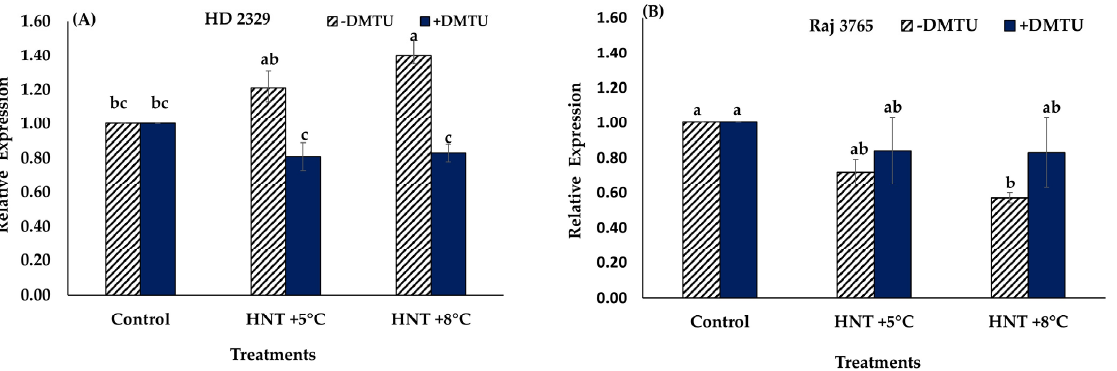
Figure 10. Effect of HNT on relative expression of TaGAPC2 gene in pistil of wheat genotypes HD 2329 (sensitive) and Raj 3765 (tolerant) under control, HNT (+5 °C) and HNT (+8 °C) conditions in absence ( A ) and presence ( B ) of ROS scavenger (DMTU). Bars represent mean ± SE. Bars with the common letter are not significantly different between temperature treatments in a genotype at p < 0.05.